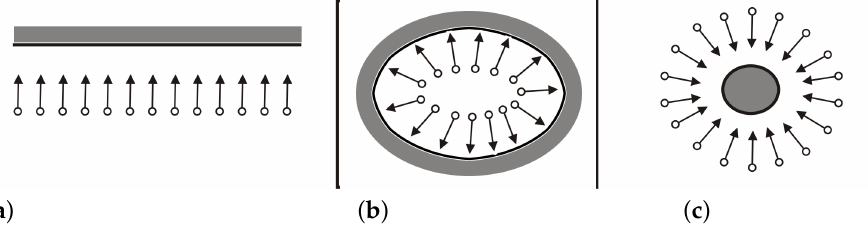
Figure 2. Photo acquisition strategy for photogrammetry: parallel ( a ); interior ( b ); object-focused ( c